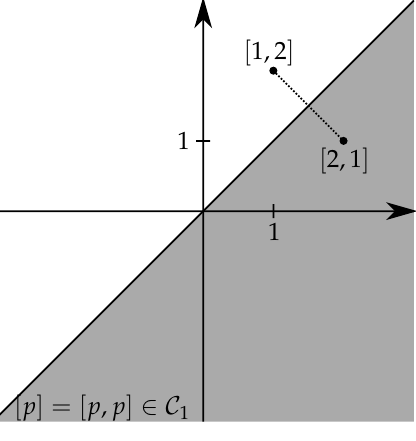
Figure 3. The space C 2